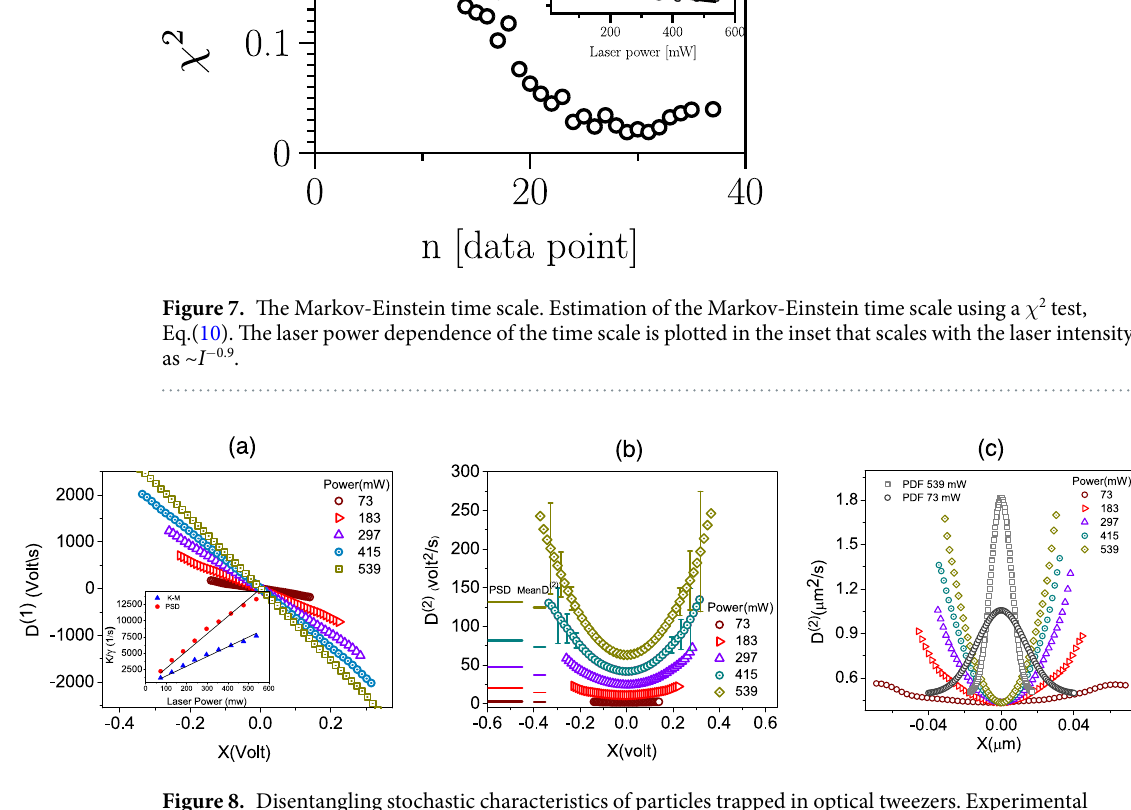
Figure 8. Disentangling stochastic characteristics of particles trapped in optical tweezers. Experimental results: The drift ( a ) and diffusion coefficients ( b ) for 5 laser powers. The drifts estimated by the PS method are embedded in the inset of ( a ). The small colored lines in ( b ) show the constant diffusion coefficients estimated by the PS method, as well as the average diffusion coefficients. ( c ) The graphs in ( b ) re-plotted after converting the position to the SI unite using Eq. (5) with D V being the intercept of the relevant graph. The gray and black graphs show the probability distribution in the presence of the bead as a function of the position for the lowest and highest laser